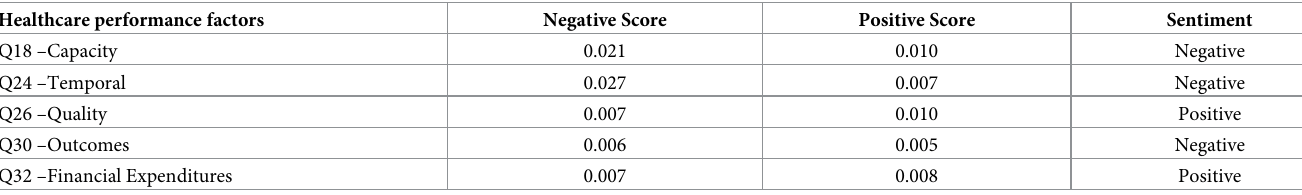
Table 3. Weighted sentiment